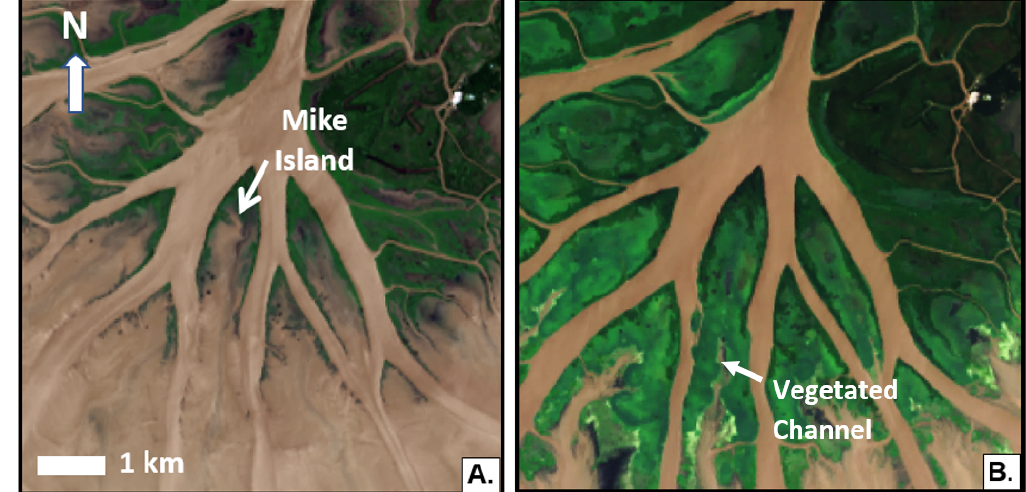
Figure 9. LANDSAT images processed using data from the USGS [56] and analyzed by the Earth Scan Laboratory at Louisiana State University (LSU). Images show the vegetation cover on Mike Island during ( A ) low density and biomass on 19 April 2015, and ( B ) the peak end of summer productivity on 25 August 2015.